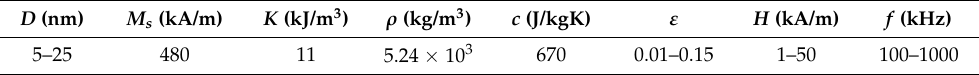
Table 1. The values of characteristic observables of Fe 3 O 4 nanoparticles and alternating magnetic field (AMF) parameters; D is the diameter, M s is the spontaneous magnetization, K is the anisotropy constant, ρ is the material density, c is the specific heat, and ε is the volumic magnetic fraction. D (nm) M s